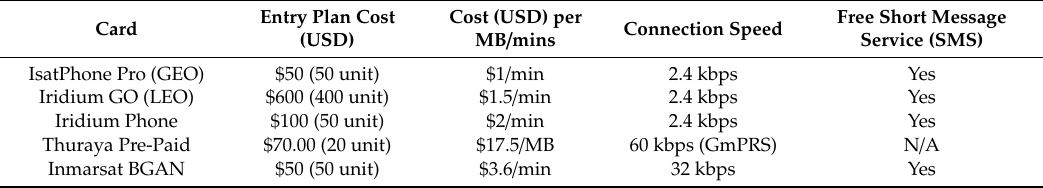
Table 1. The price of a prepaid SIM card for connecting to a satellite